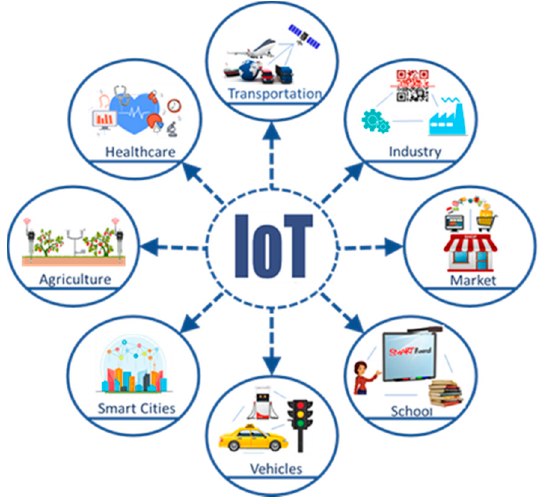
Figure 1. Illustration of an Internet of Things (IoT) general framework with several vertical applications.